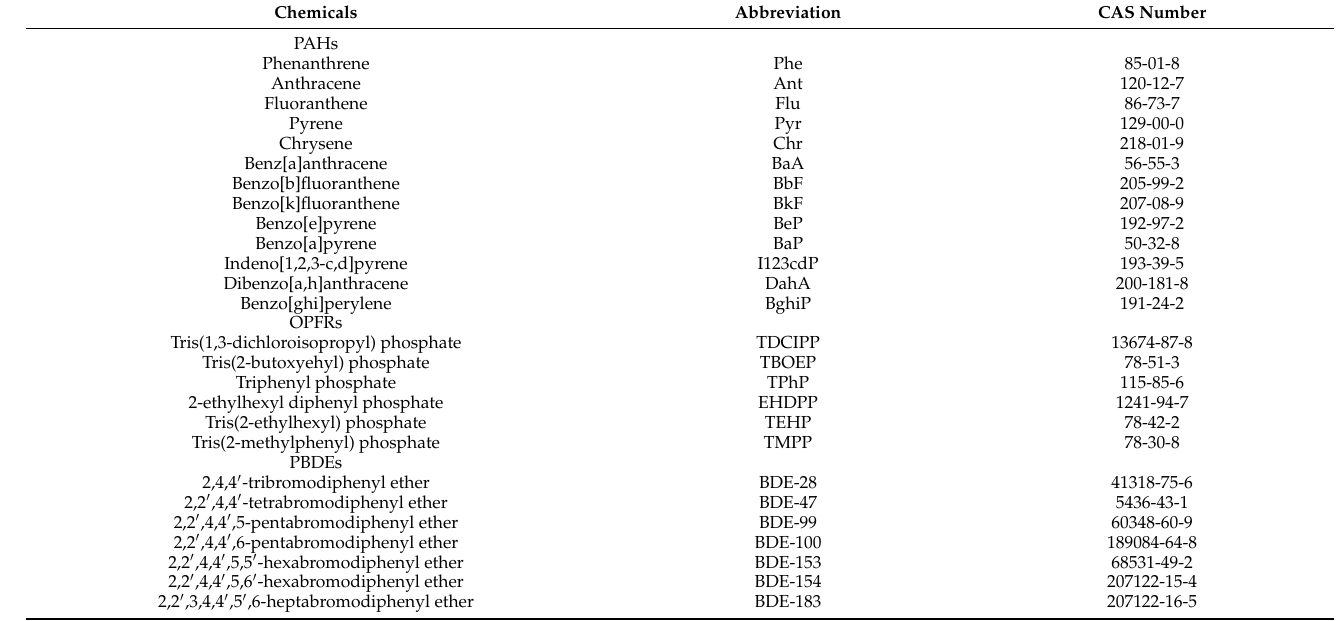
Table 1. List of targeted